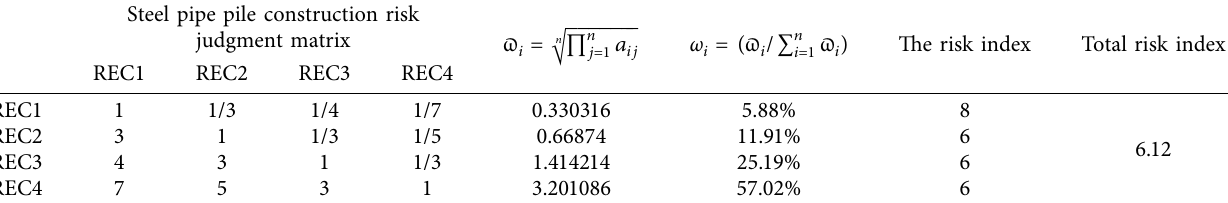
Table 21: Steel pipe pile construction risk judgment matrix.